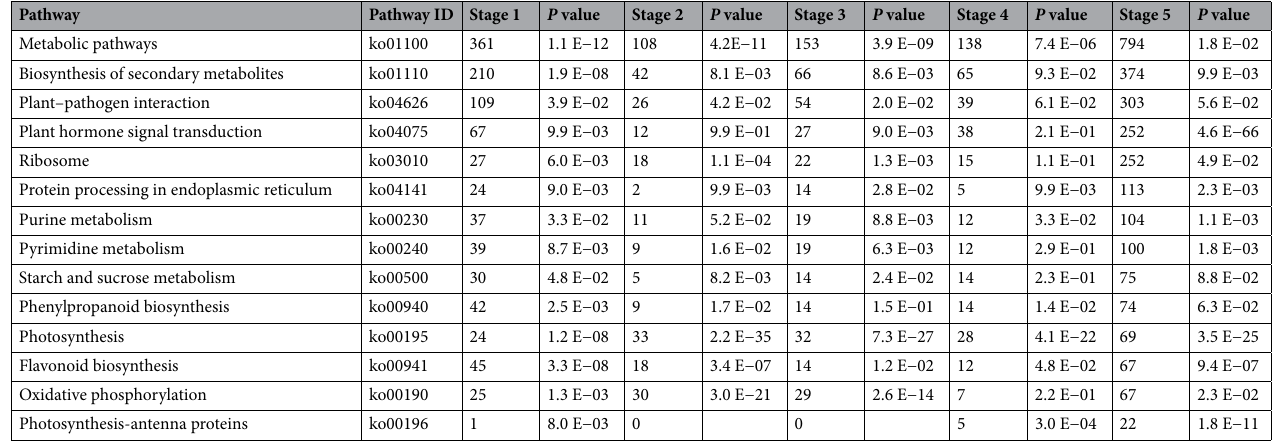
Table 2. Number of DEGs in enriched KEGG pathways in five seed developmental